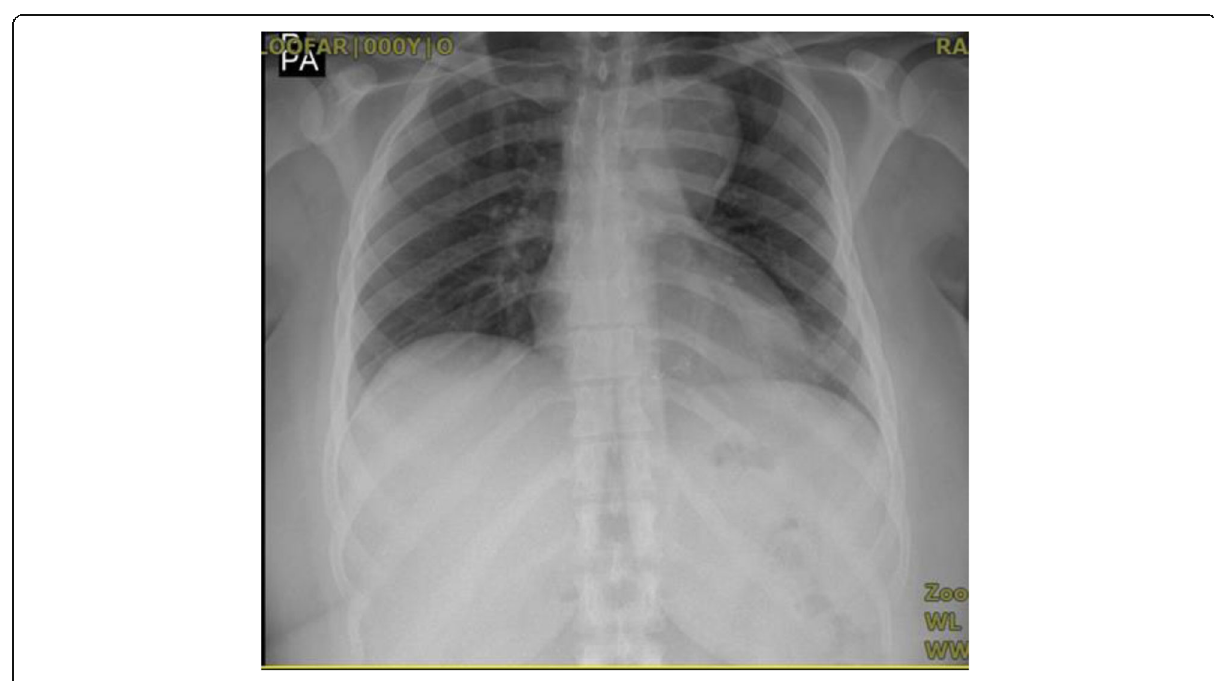
Fig. 1 CXR depicting aneurysmal dilation of the aorta